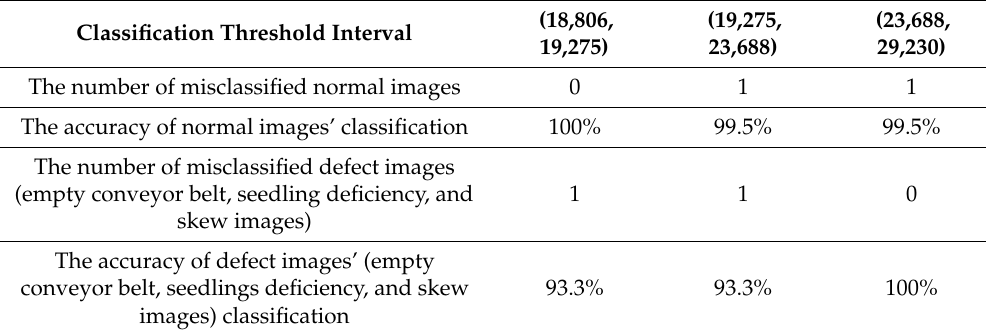
Figure 13. Feature scatter plot of the seedling area. Table 3. Analysis of the seedling defect identification threshold.